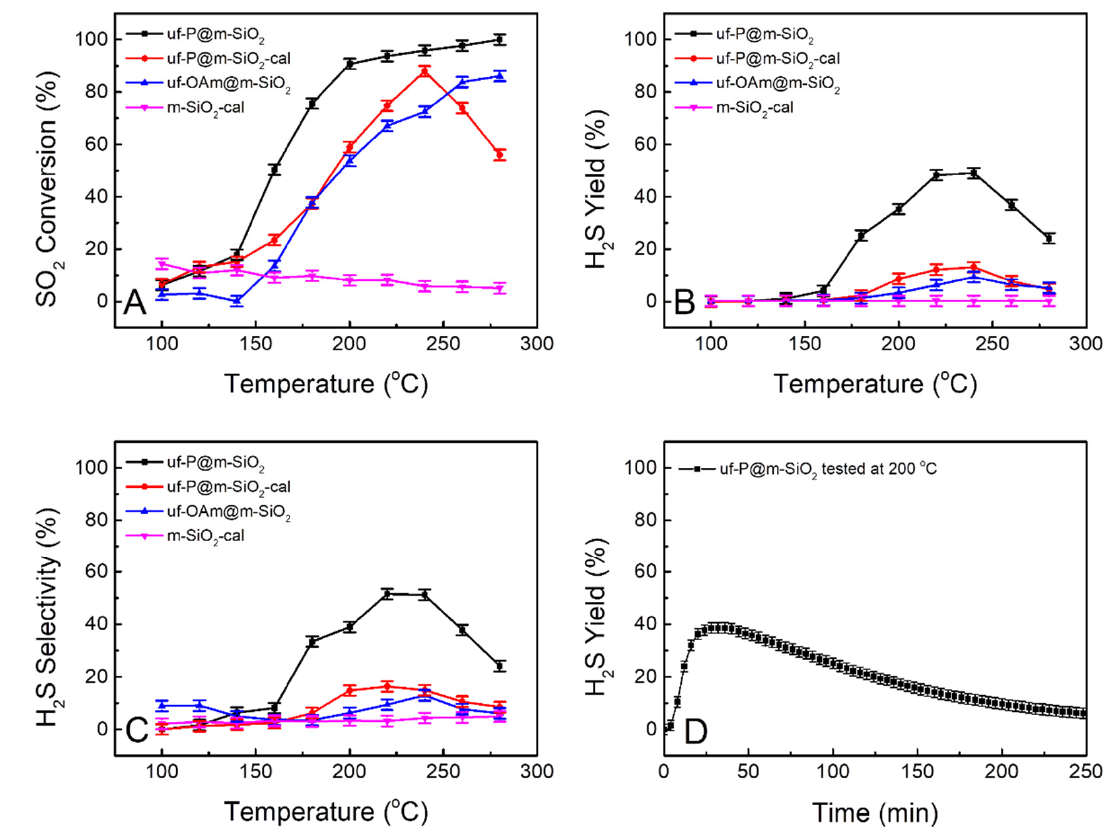
Figure 7. Curves of SO 2 conversion ( A ), H 2 S yield ( B ), and H 2 S selectivity ( C ) obtained from uf-P@m-SiO 2 , uf-P@m-SiO 2 -cal, uf-OAm@m-SiO 2 , and m-SiO 2 -cal at the temperature of 100 °C to 280 °C. H 2 S yield of uf-P@m-SiO 2 long-term test at 200 °C ( D ).